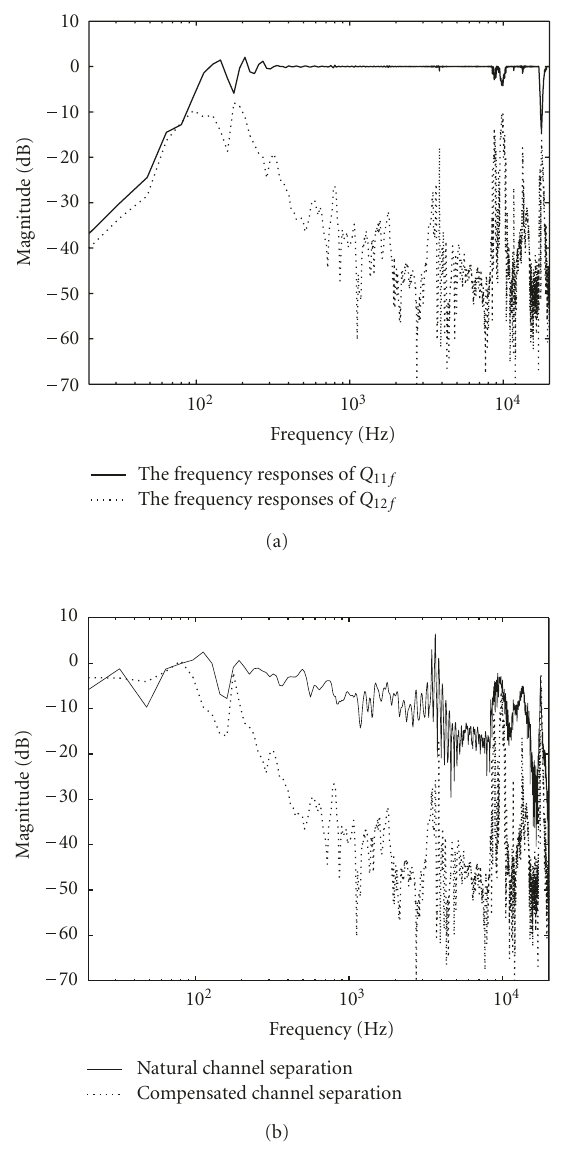
Figure 4: (a) The frequency responses of Q 11 f and Q 12 f . (b) Natural channel separation and compensated channel separation.